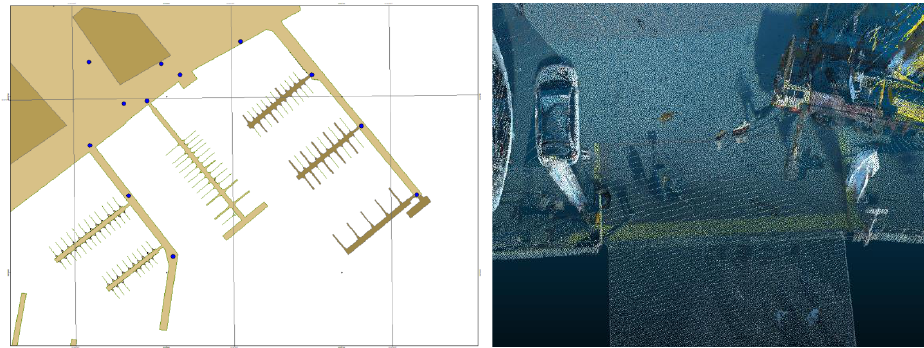
Figure 7. A part of TLS stations (left) and visualization of one of them close to slipway (right).